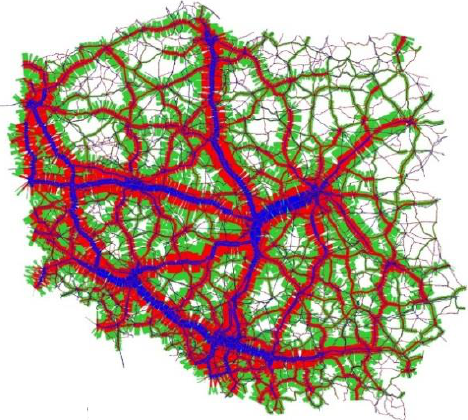
Fig. 4. The level of emissions of harmful compounds by passenger transport in 2020 in g/km (legend: blue line – HC, red line – CO,